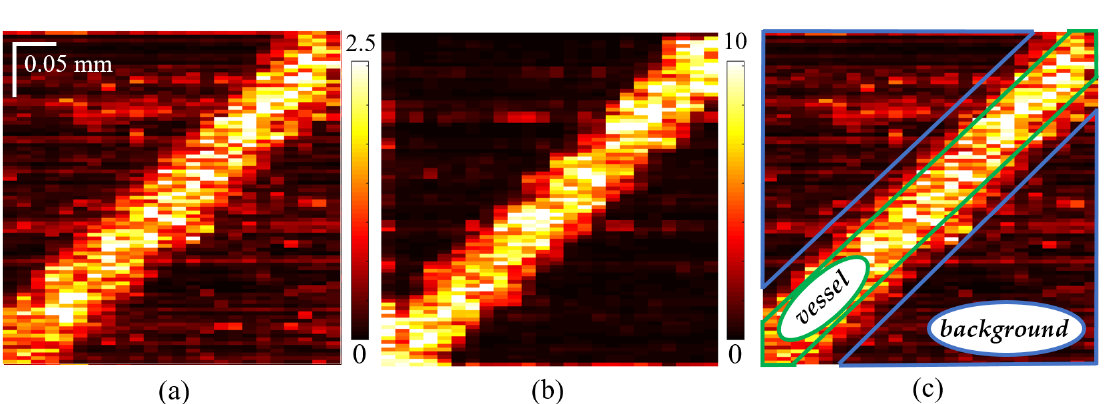
Figure 7. Comparison of high pass filtration ( a ) and OCA-S ( b ) methods for simulated data. OCA-S en face image has lower background signal and has fewer strain-induced artefacts. Panel ( c ) illustrates areas used for calculation of ratio of mean signal inside the vessel (green figure) to mean background signal (blue triangles). The scale bar is 0.05 mm.